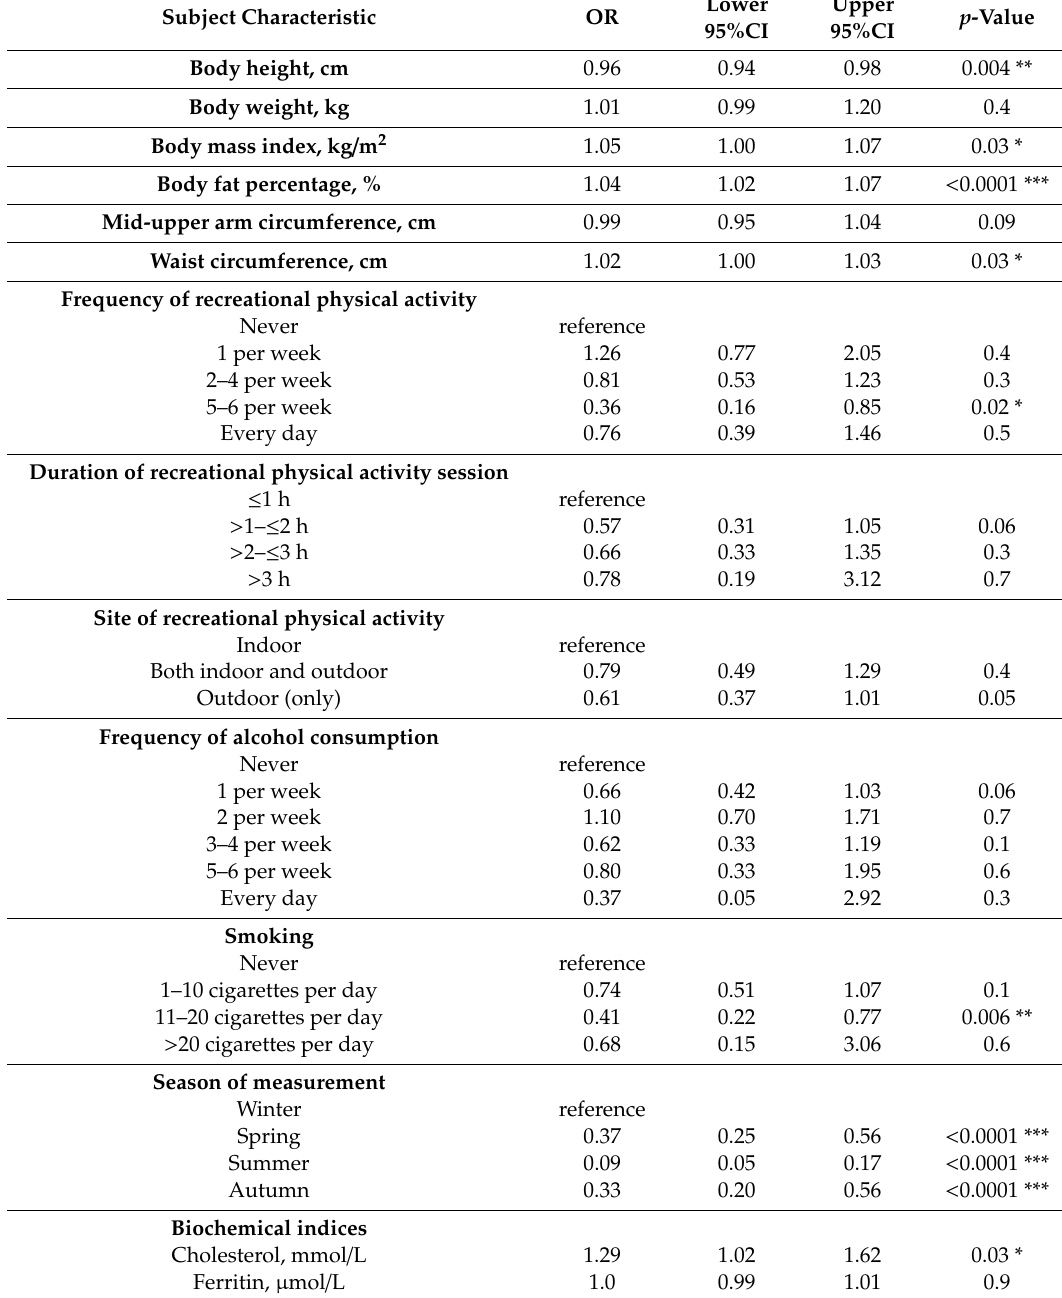
Table 3. Odds ratios (ORs) of 25-hydroxy-vitamin D insu ffi ciency and corresponding 95% confidence intervals (CIs) from univariate logistic regression